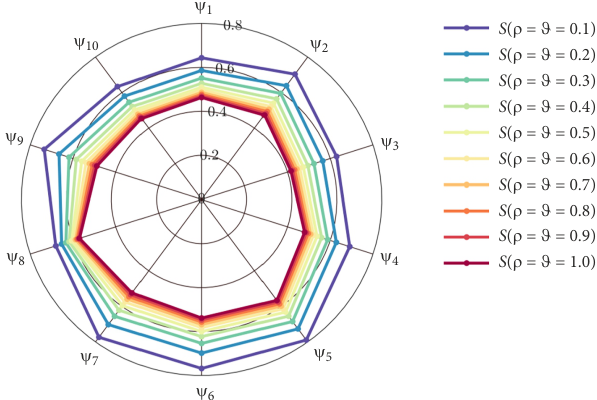
Figure 2. The variation trend of S i with J ∈ [0,1] and r ∈ [0,1]